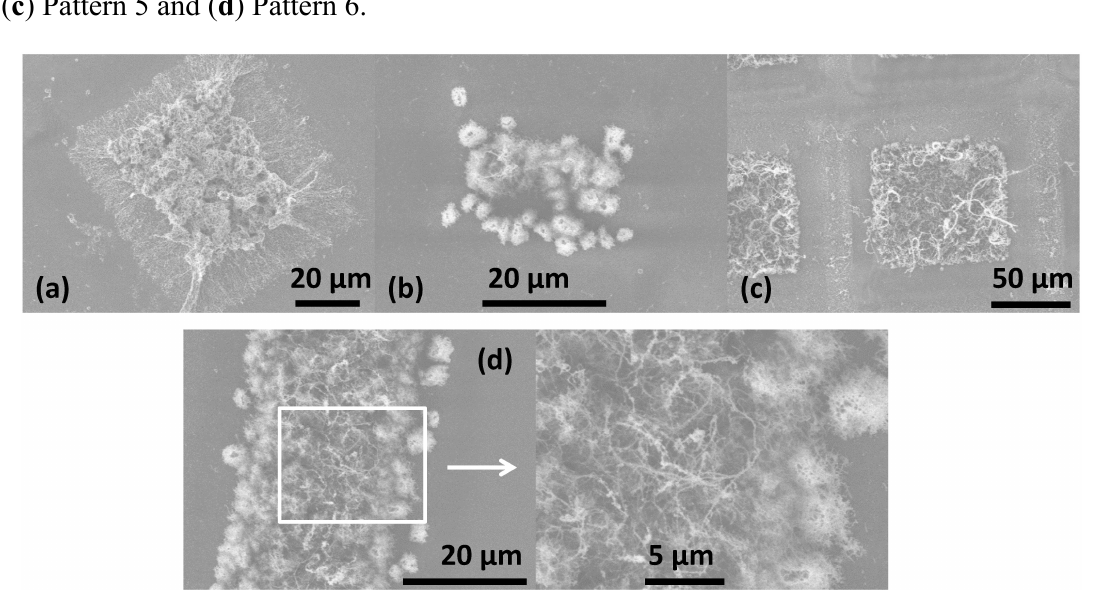
Figure 4. SEM images of the CNT micro-pillars and a micro-line: ( a ) Pattern 2, ( b ) Pattern 4, ( c ) Pattern 5 and ( d ) Pattern